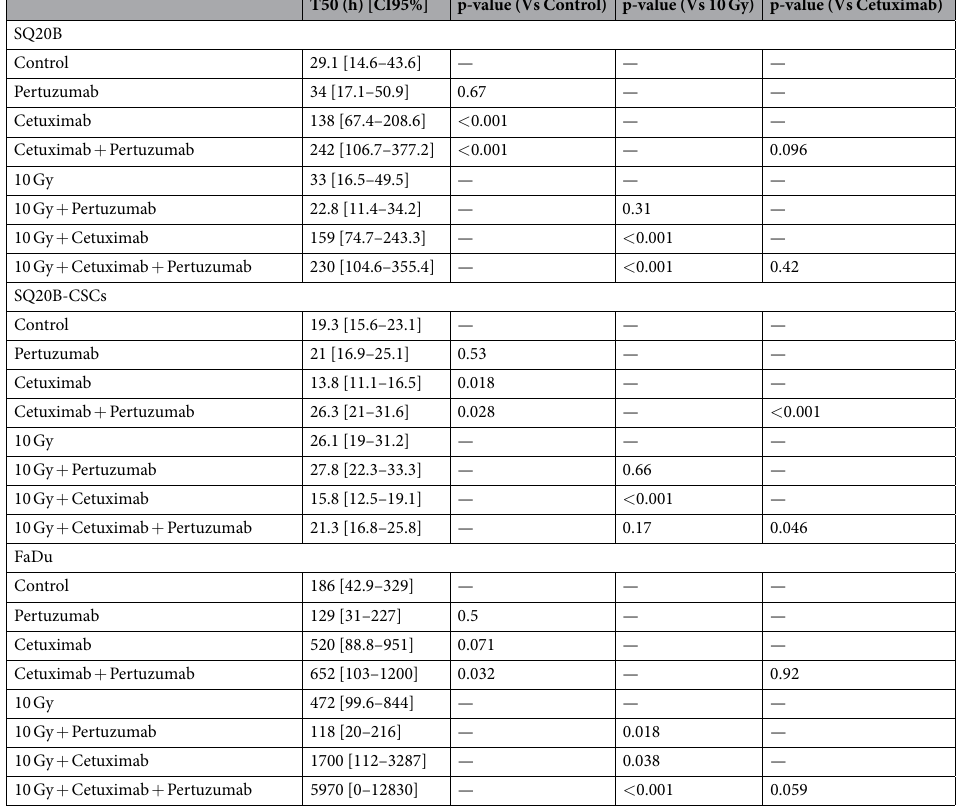
Table 3. Cell invasion expressed with time to heal 50% of the wound (T50) and p-values. Leg. T50 (h): time to heal 50% of the wound in hours; CI95%: confidence interval; Vs: versus; Gy: Gray